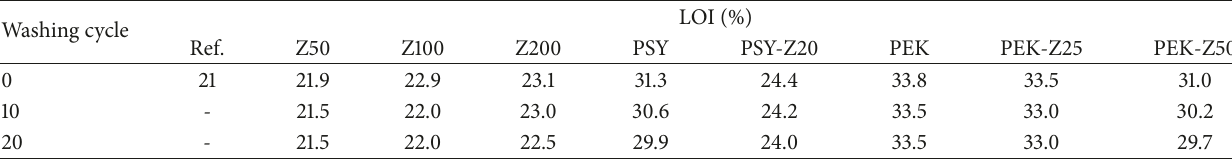
Table 5: LOI test results of the samples.